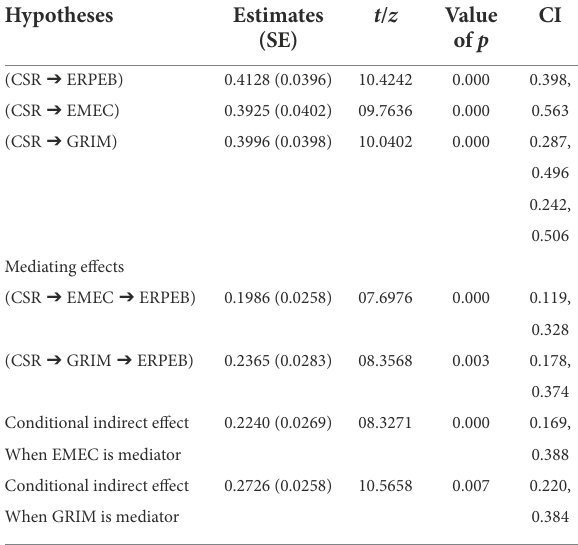
TABLE 7 Hypotheses